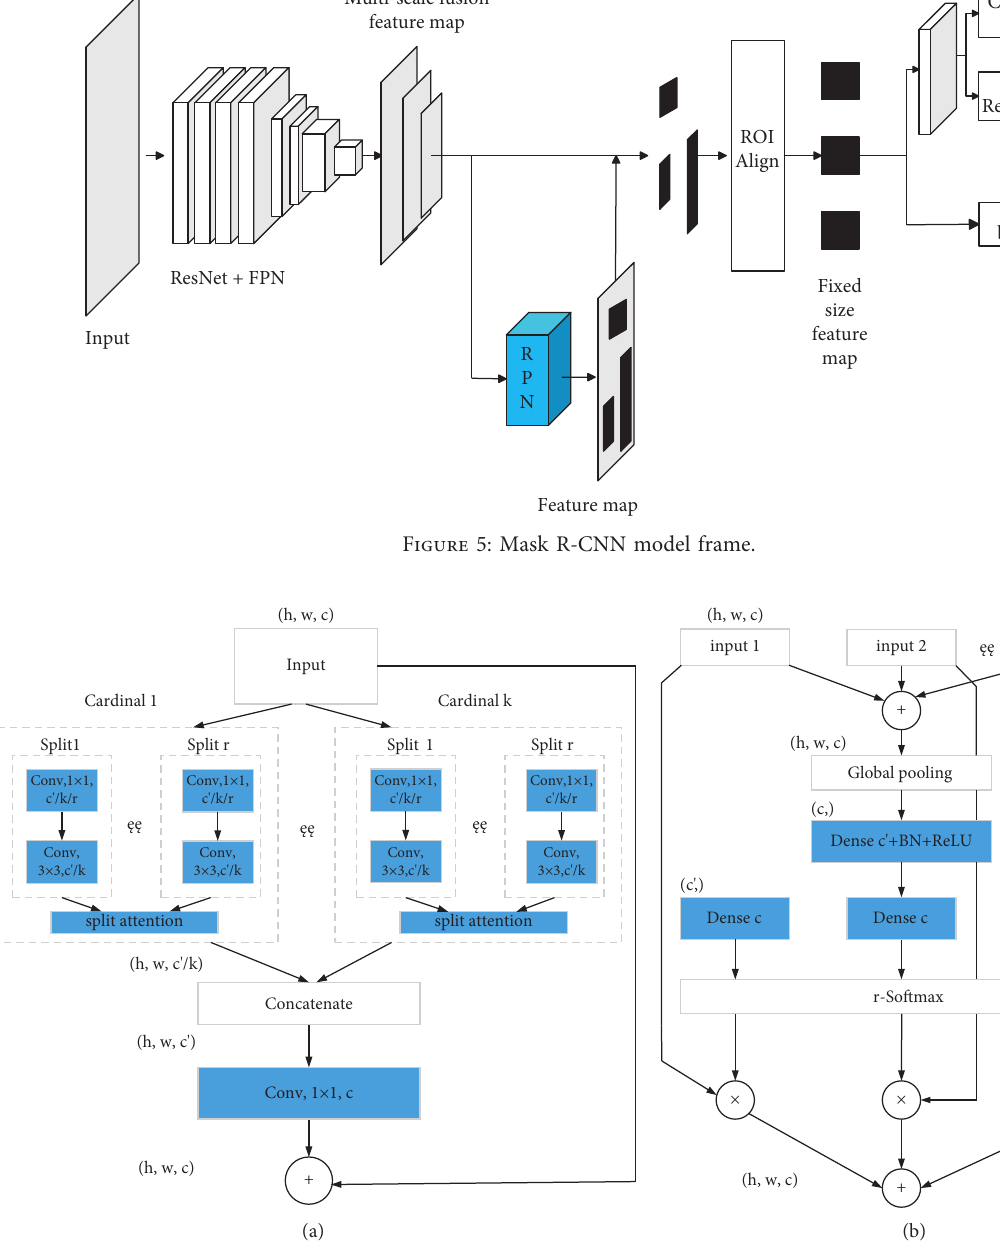
Figure 6: ResNeSt block and split attention module. (a) ResNeSt block. (b) Split attention.